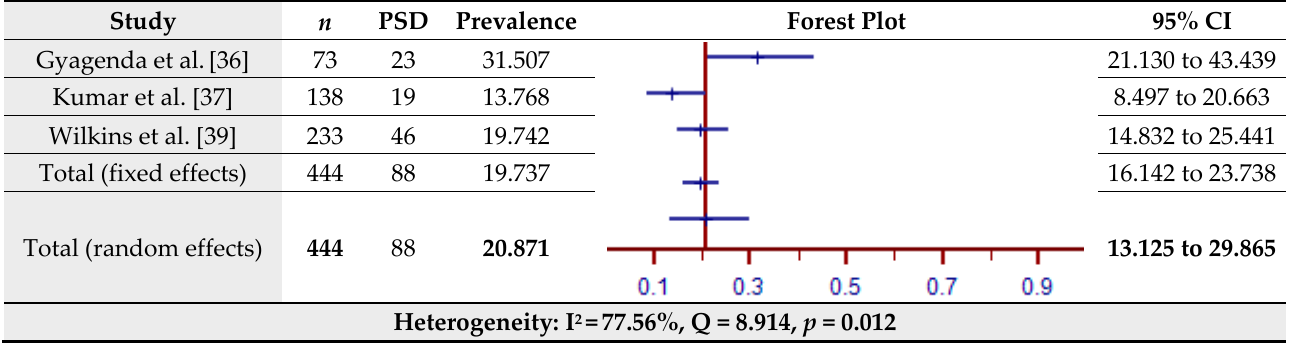
Figure 5. Prevalence estimates of Post-Stroke Depression (PSD) assessed by the Patient Health Questionnaire (PHQ-9).